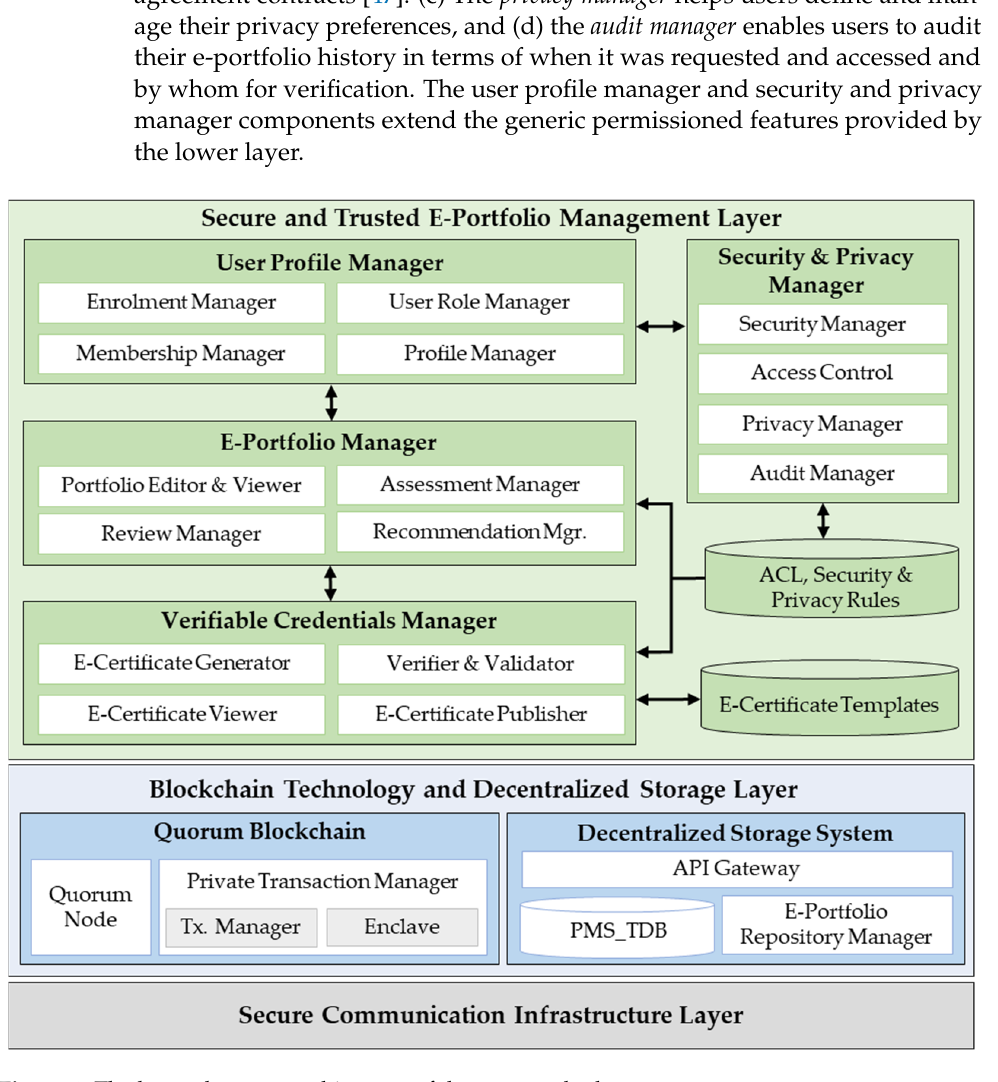
Figure 4. The layered system architecture of the proposed